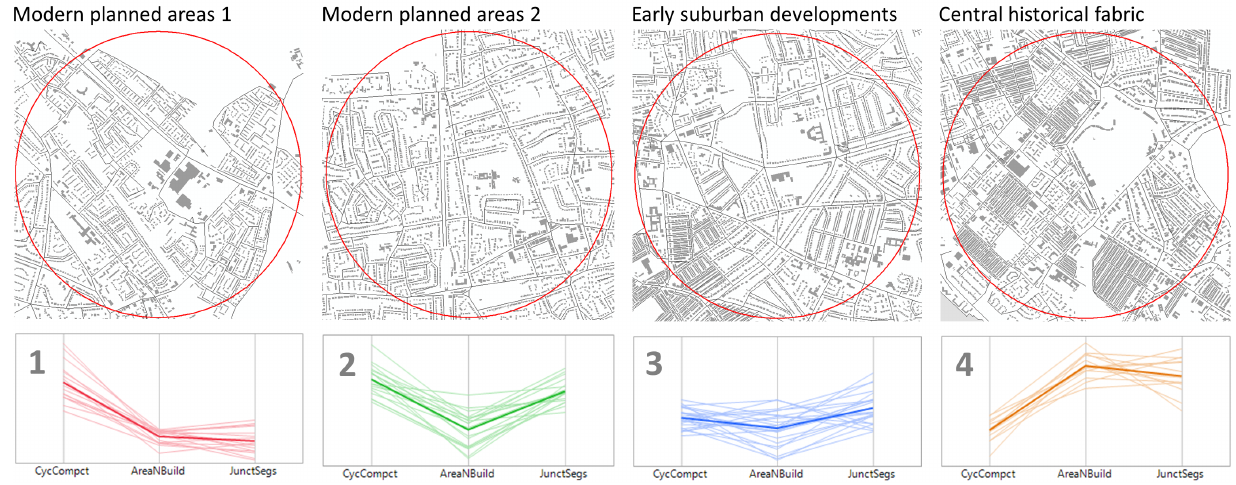
Figure 8. Archetypes and numerical profiles of the four morphological